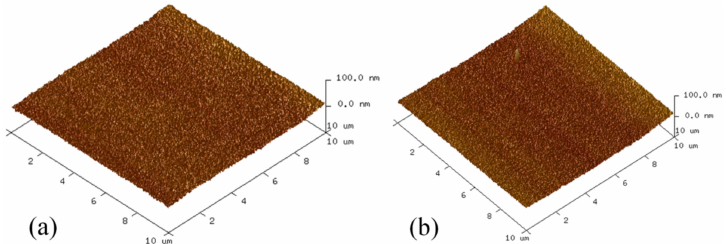
Figure 8. AFM images of Au surface. ( a ) Before pretreatment. ( b ) After